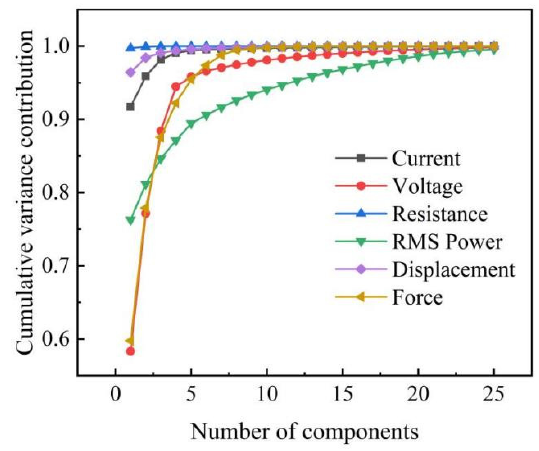
Figure 4. Cumulative variance contribution rate of different signals.